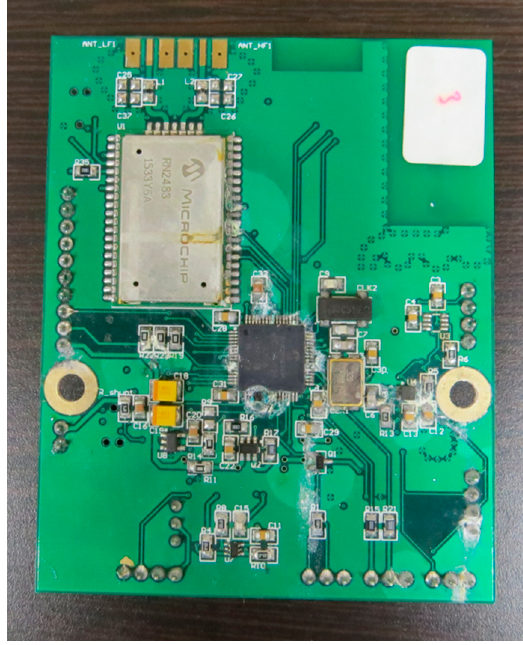
Figure 17. Water damaged sensor node.